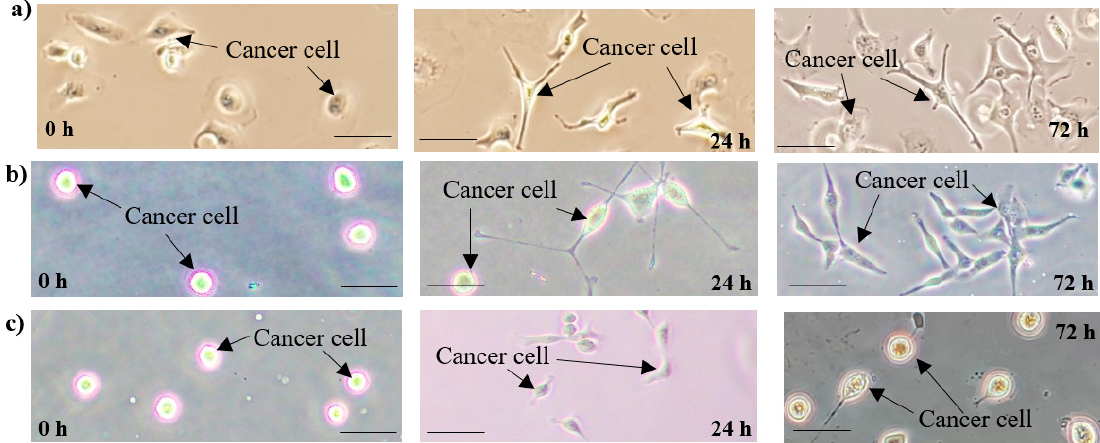
Figure 7. Microscope images of cancer cell cultures developed: ( a ) on a Petri dish in the incubator; ( b ) in the lab-on-chip device placed in the incubator (no medium flow), ( c ) utilizing the LOC platform (constant medium flow)—visible change in cells morphology. Scale bar—20 µm.